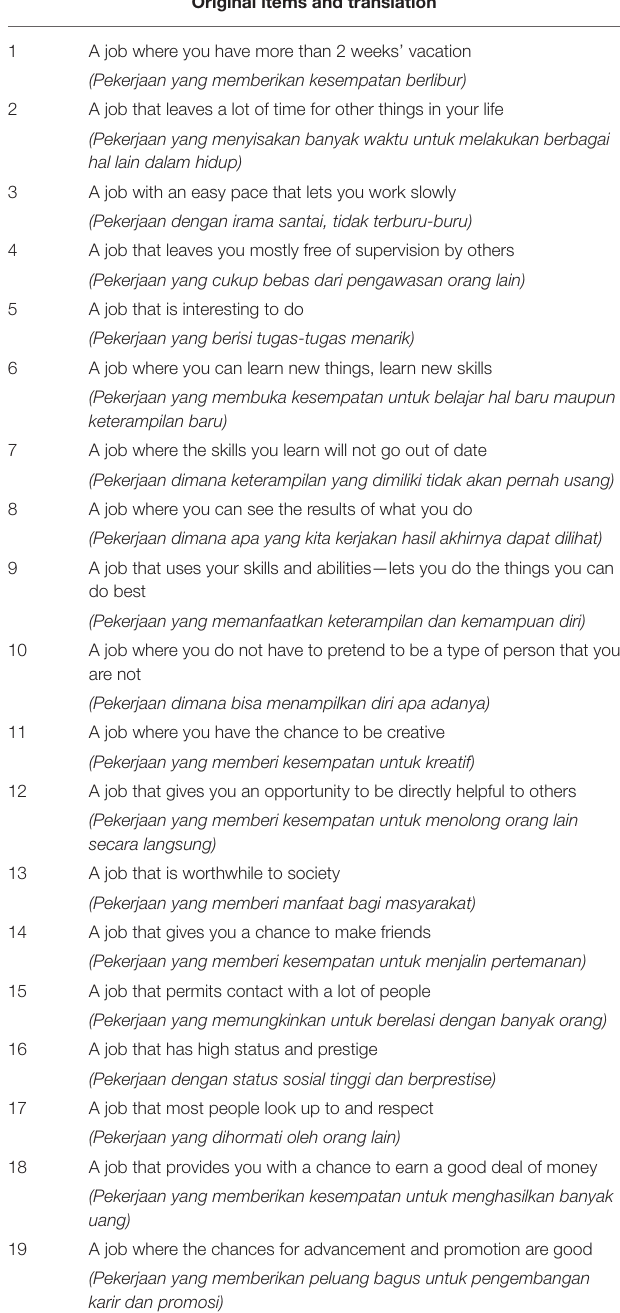
Original items and